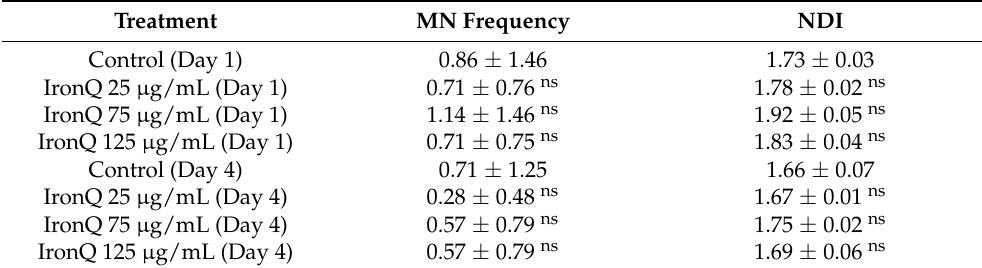
Figure 6. Micronucleus analysis of PBMCs after labeling with IronQ. ( A ) Representative image of PBMCs showing binucleated cells. ( B ) The micronucleus formation among the binucleated cells. ( C ) The graph shows the micronucleus formed among the binucleated cells in PBMCs after labeling with different concentrations of IronQ. Data are expressed as mean ± SD of eight independent samples. The data represent 1000 binucleated cells and ns indicates not significantly different from control. Table 1. Micronucleus (MN) formation frequency among the 1000 binucleated cells and the nuclear division index (NDI) in PBMCs after labeling with different concentrations of IronQ ( n = 8).